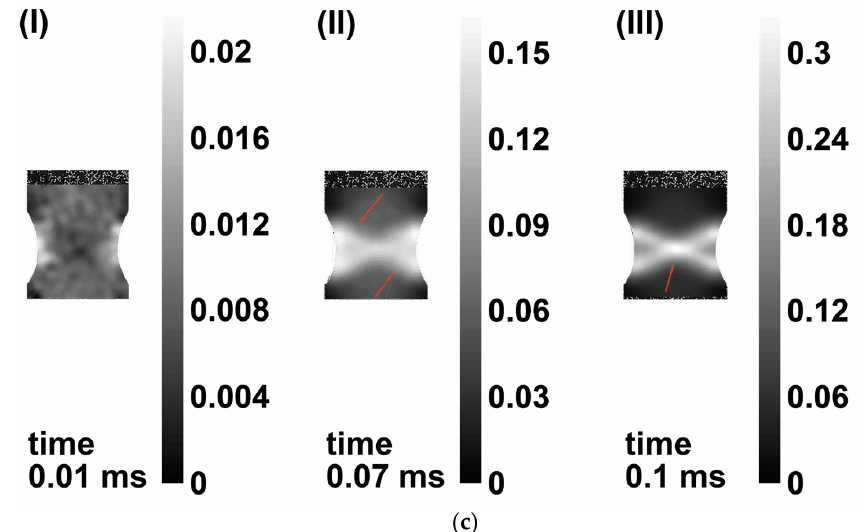
Figure 7. Fields of equivalent strain of specimens with the notch radius of 5mm at ( a ) 0.1 s − 1 , ( b ) 100 s − 1 , and ( c ) 1000 s − 1 .